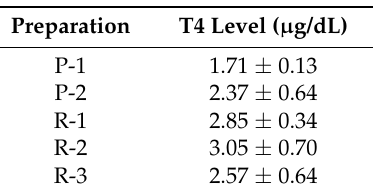
preparations: X = 2.82 ± 0.24 ( CV = 8.5%).